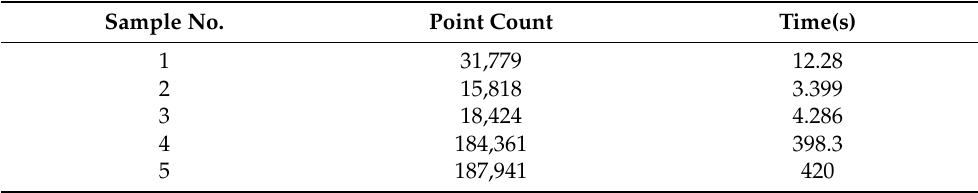
Table 4. Time consumption for the data processing of the five samples. Sample